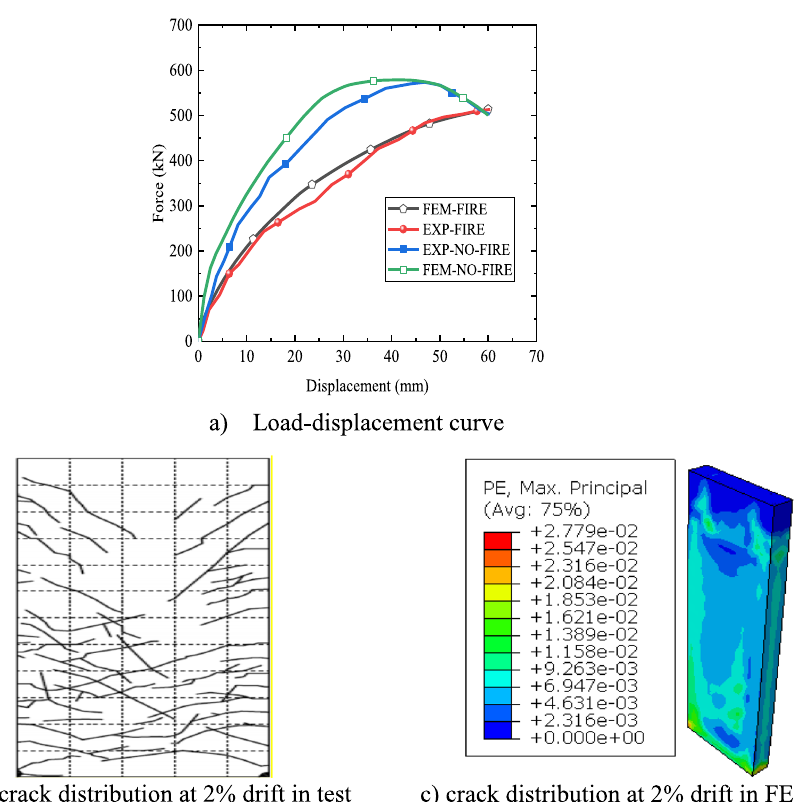
Fig. 34 Comparison of load-displacement curve ( a ) and crack distributions at drift of 2% in test and FEM ( b and c )